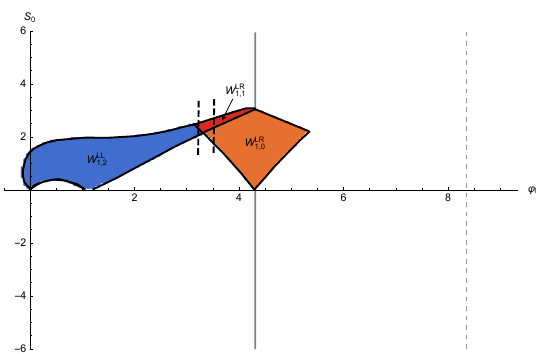
, W LL and W LR space of solutions. 1 , 0 1 , 2 1 , 1